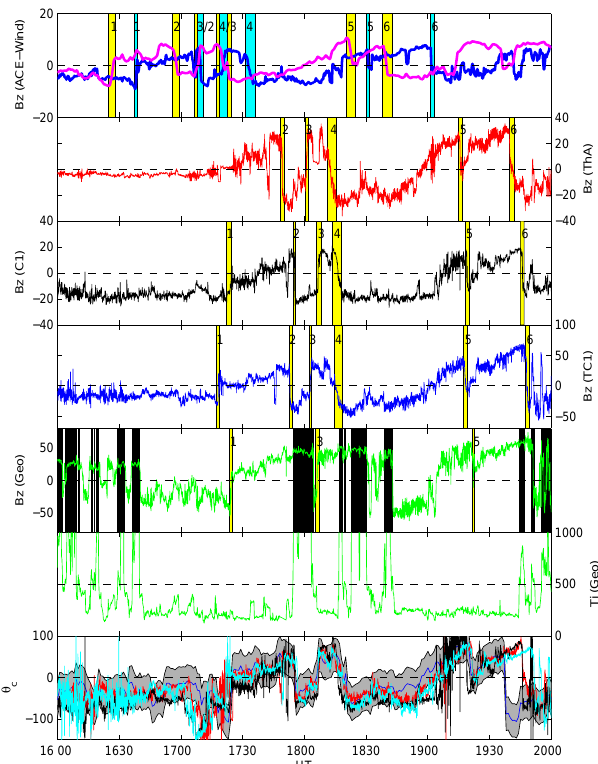
Fig. 2. The B z data for ACE (blue) and Wind (magenta), THEMIS A, Cluster 1, TC1 and Geotail. The shaded (yellow for ACE and cyan for Wind in the top panel) and numbered areas are the time intervals for which minimum variance analysis was per- formed (the results shown in Table 1). The black shaded intervals in the Geotail panel show where the spacecraft was inside the magne- tosphere. The bottom panel shows the clock angle of the magnetic field for Wind, THEMIS A, Cluster 1 and TC1, with the data shifted as to match with Cluster 1. The grey shaded area around shows a region of θ c , wind ± 30 ◦